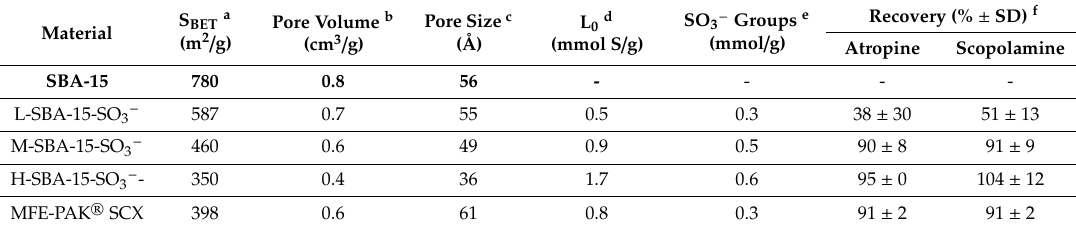
Table 1. Textural properties and functionalization degree of the prepared SBA-15 silicas compared with a commercial sorbent. Recovery percentages for atropine and scopolamine in standard solution using synthetized and commercial materials as strong cation-exchange solid-phase extraction